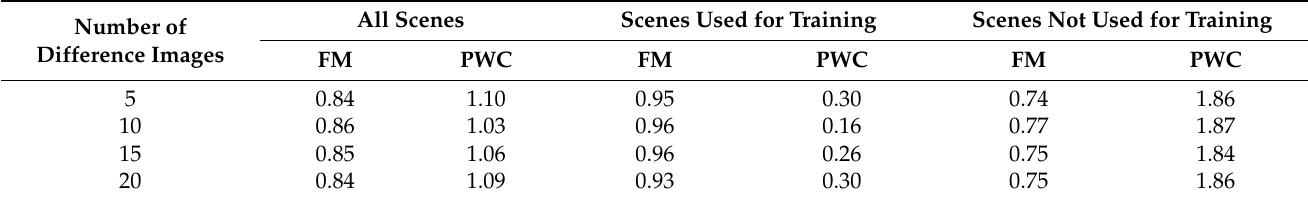
Table 6. A comparison result by changing the number of difference images under a five-frame interval.